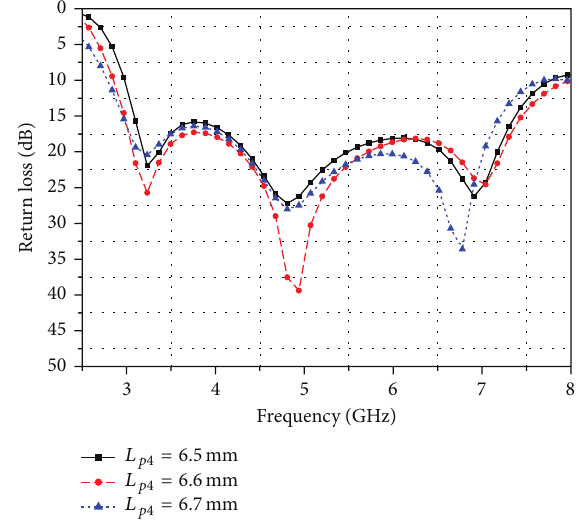
Figure 6: Simulated return loss against frequency for the proposed CPW-fed two-sided T strip wideband microstrip antenna with various values of 𝐿 𝑝4 ; other parameters are the same as listed